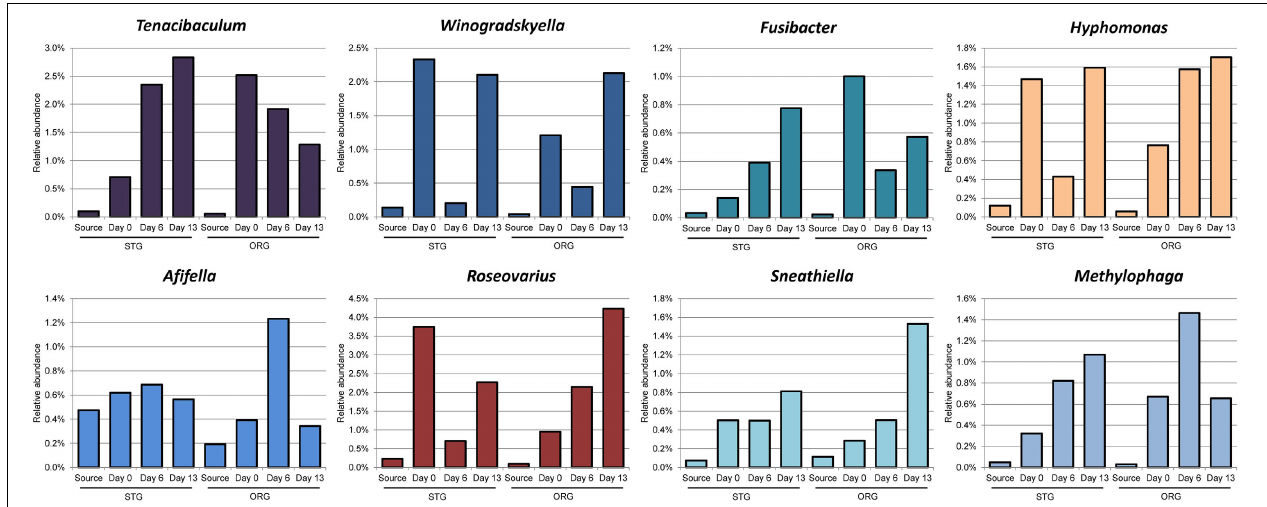
FIGURE 5 | Bacterial genera enriched within the microbial community in the mesocosm columns. Only genera demonstrating a ≥ 3-fold increase in relative abundance when compared between any two time points (Days 0, 6, and 13) of at least one sand microbial community (average of 2 replicate mesocosm columns for each beach sand source) and represented in Figure 4 . Source represents the population